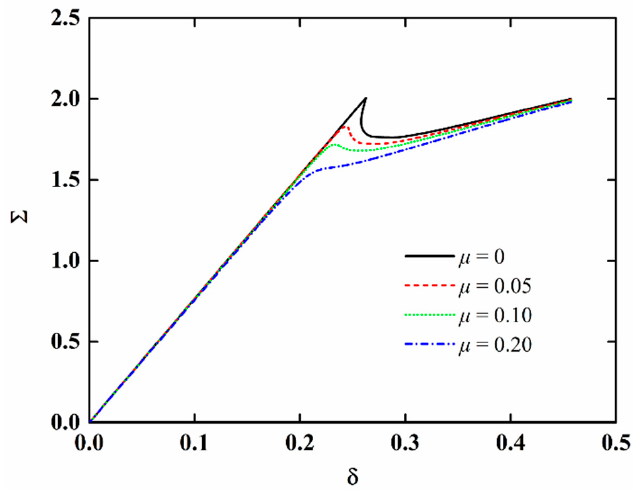
Figure 5. Load-edge shortening curves of imperfect NFRC cylindrical shells for different Figure 5. Load ‐ edge shortening curves of imperfect NFRC cylindrical shells for different imperfec ‐ imperfection tion amplitudes.